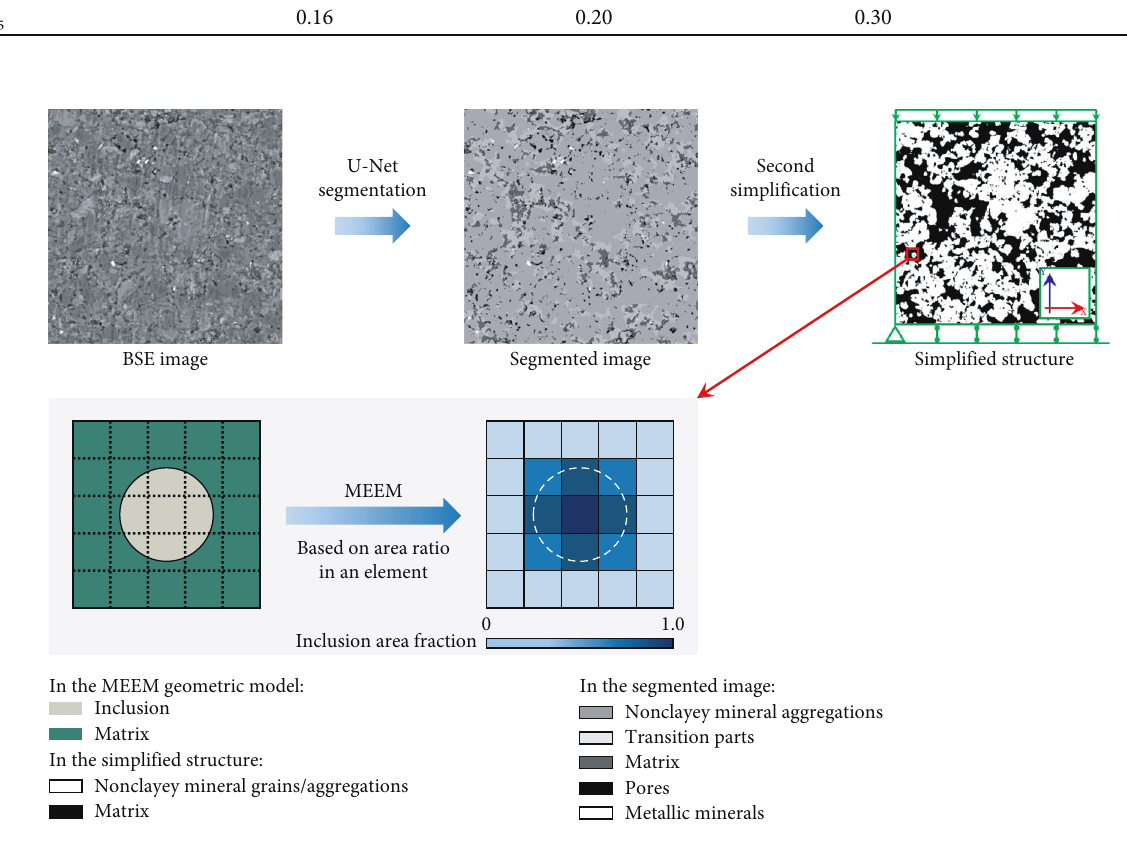
Figure 1: Schematic diagram of the image segmentation and the meso-element equivalent